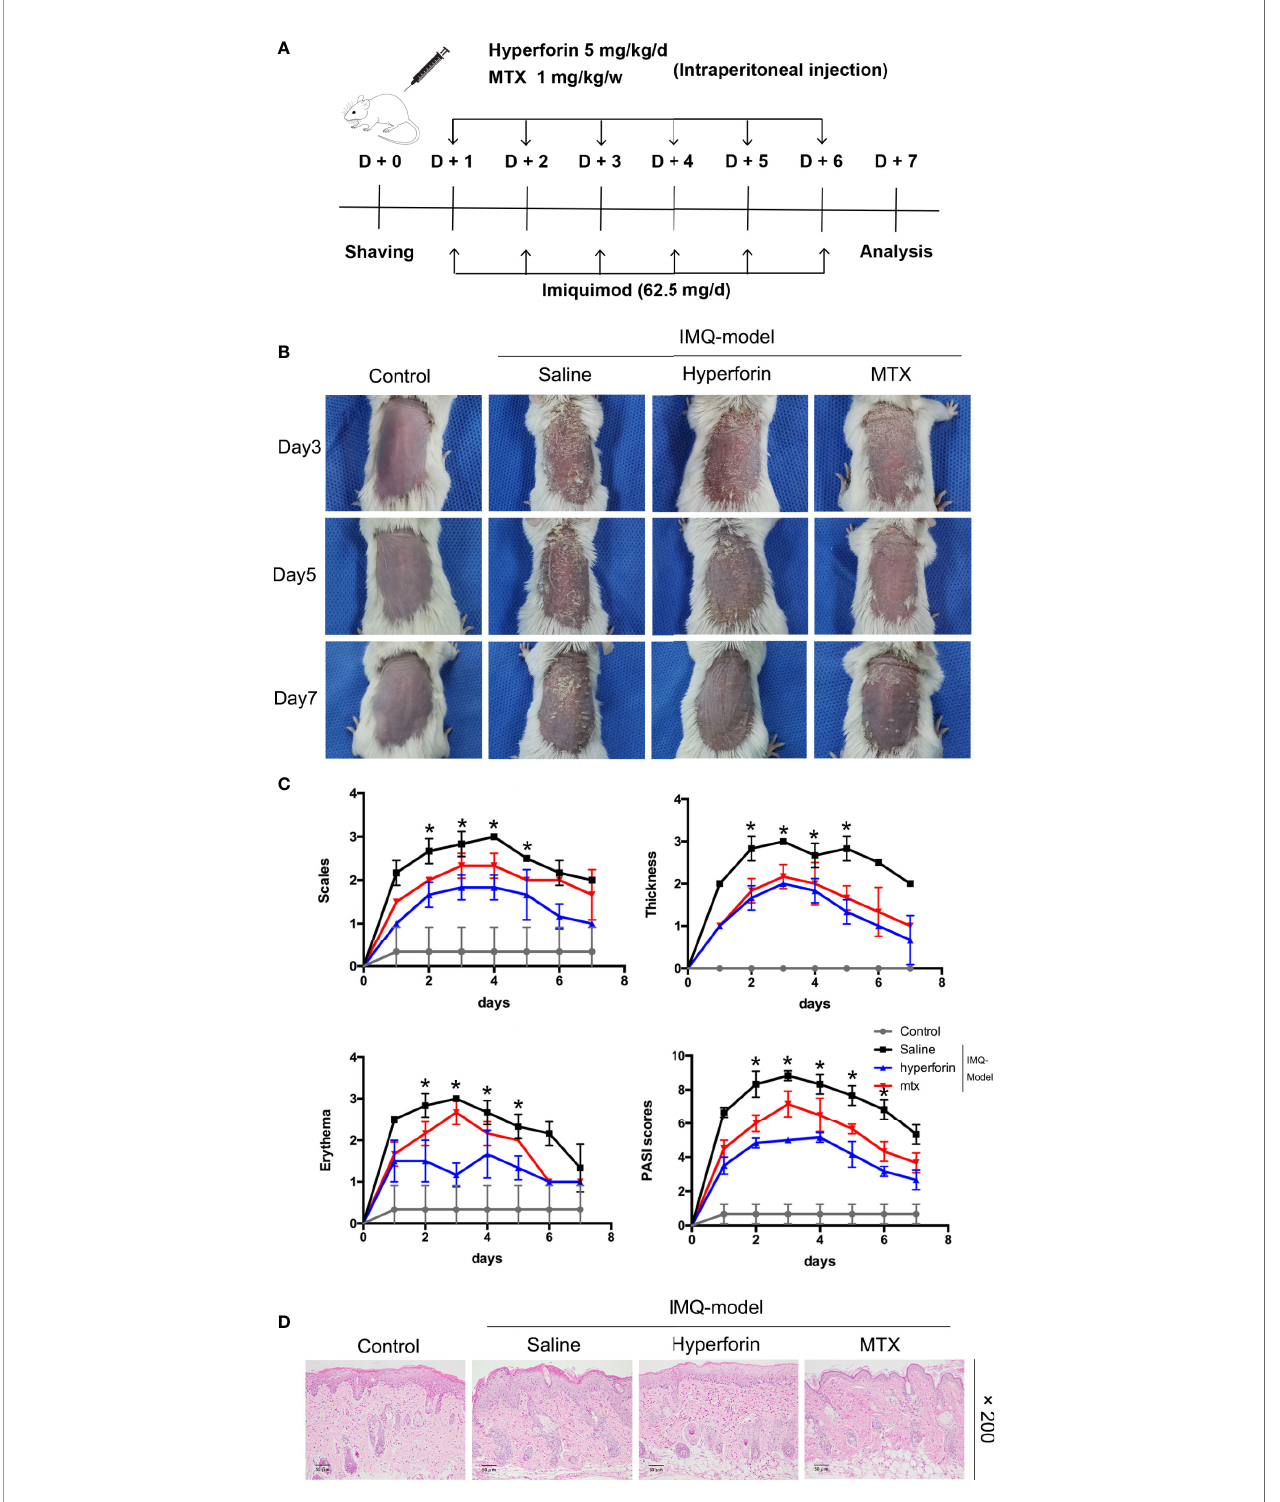
FIGURE 1 | Hyperforin ameliorates psoriatic symptoms and skin in fl ammation in IMQ-induced psoriatic mice. (A) Flow chart of this experiment. (B) The back-skin photos of mice were taken at 3th, 5th, 7th day after IMQ painting. (C) PASI scores in all groups of mice were evaluated daily and the statistical difference between all groups at 8th day was indicated. (D) H&E staining of the dorsal skin with the original magni fi cation of 200×. Data are expressed as mean ± SD (n = 5 mice/group, *p < 0.05 vs . Model). One representative of three separate experiments is shown while all results were similar among these three